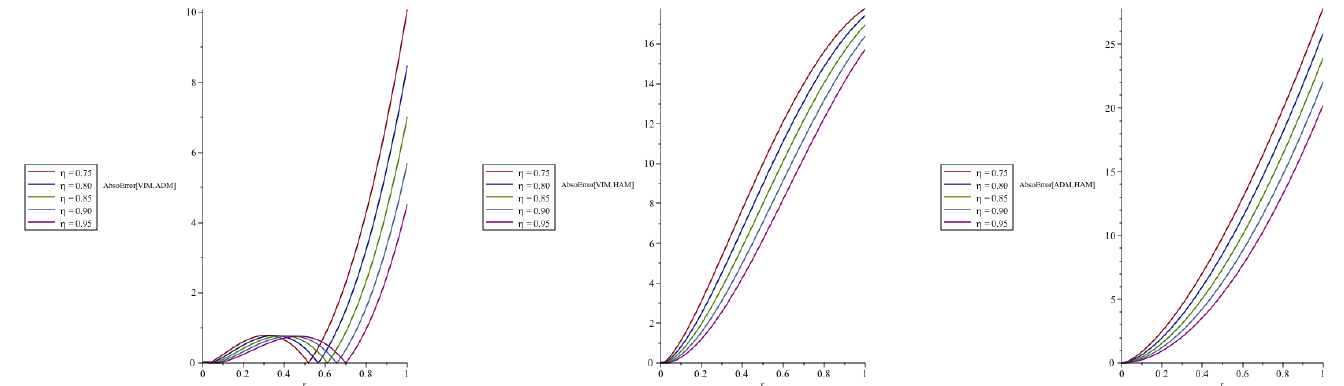
Figure 8. Plot of the absolute errors at χ = 0.1 for different values of η when ¯ h = − 1 for Example